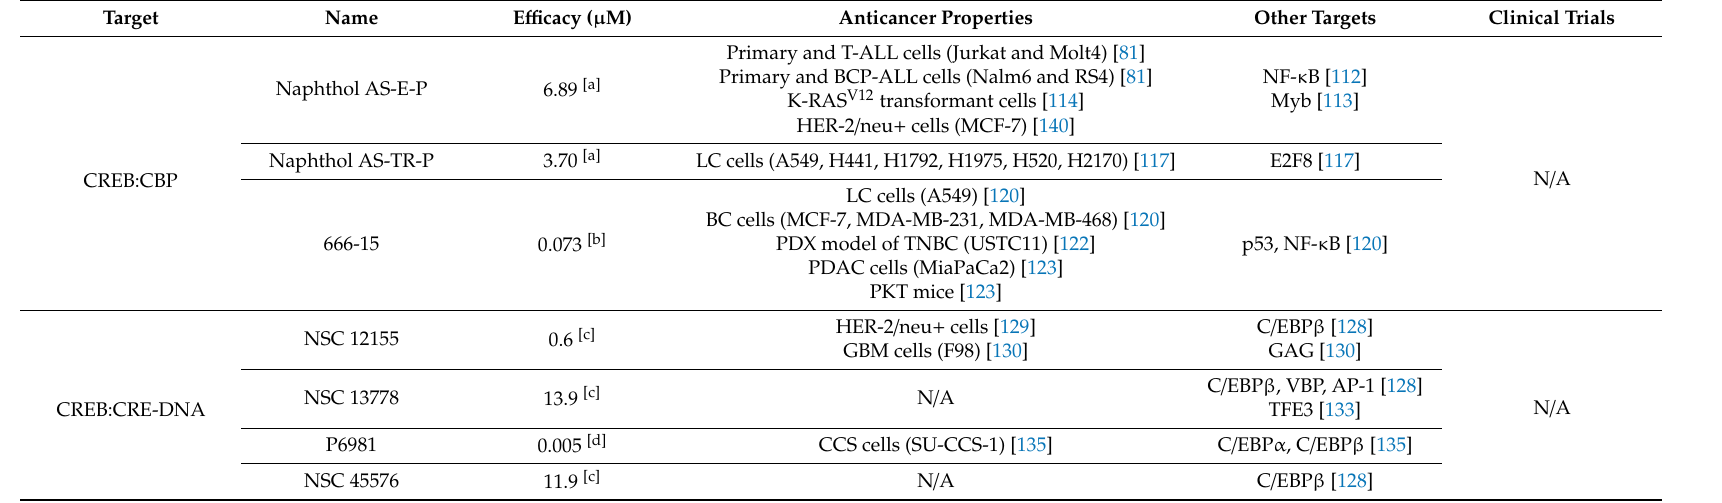
Table 1. Schematic summary of major existing CREB